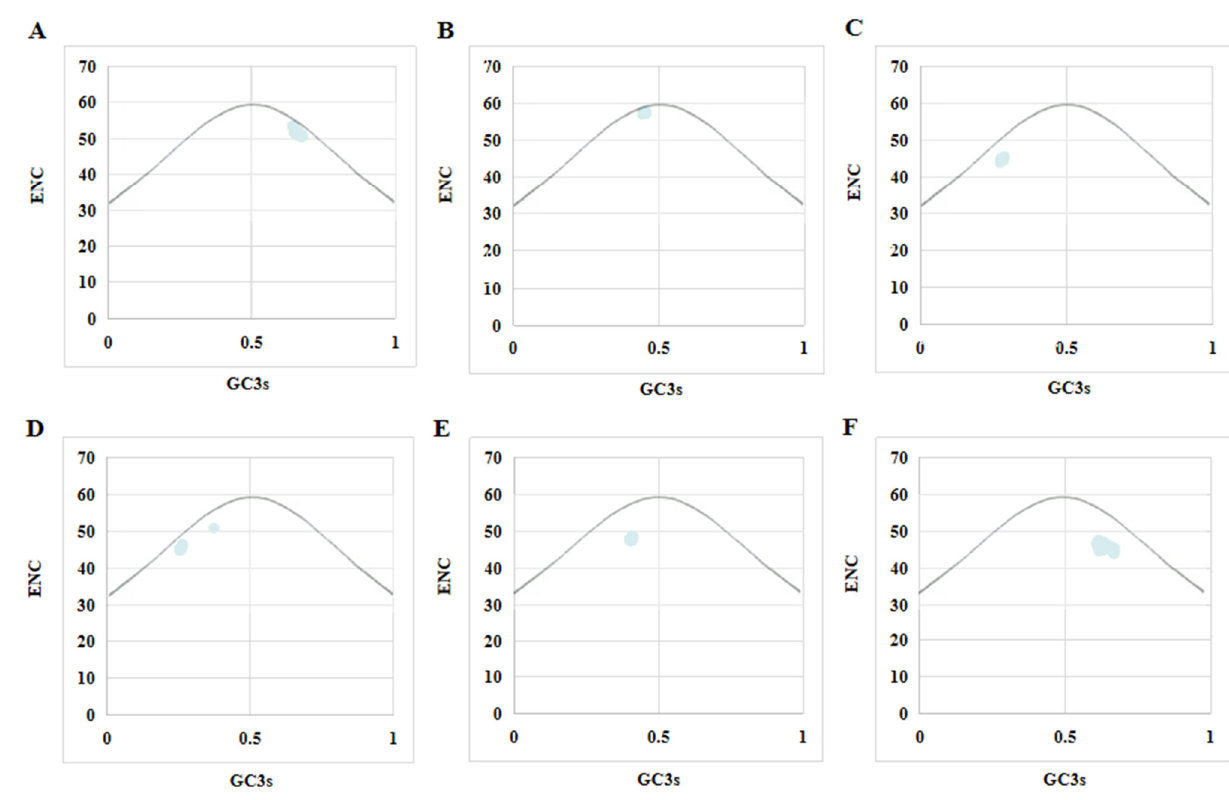
Figure 4. The relationship between ENC and GC3 of each sub-type of PPV. ( A ): PPV2 . ( B ): PPV3. ( C ): PPV4. ( D ): PPV5. ( E ): PPV6. ( F ):